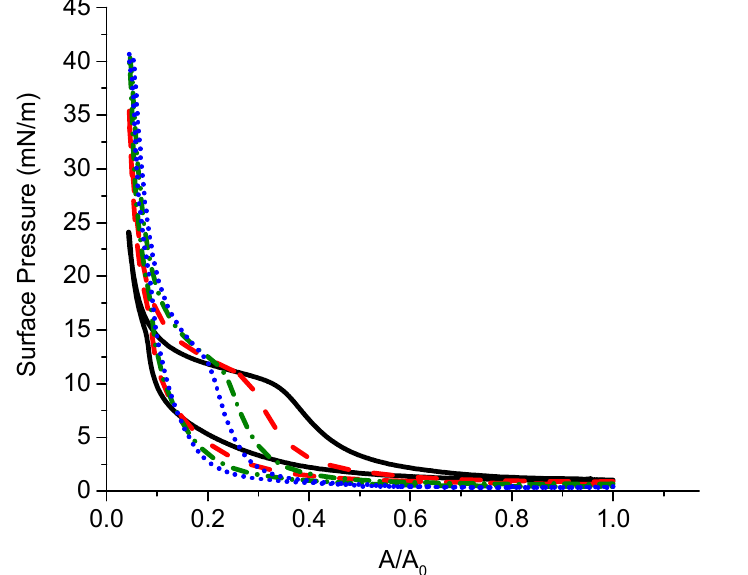
Figure 1. Surface pressure vs. relative surface area A/A0 of a PDAHMAC layer spread onto buffer solution. Lines correspond to consecutive compression-expansion cycles: first cycle (black), second cycle (dashed red), third cycle (dash-dotted green) and fourth cycle (dotted blue).